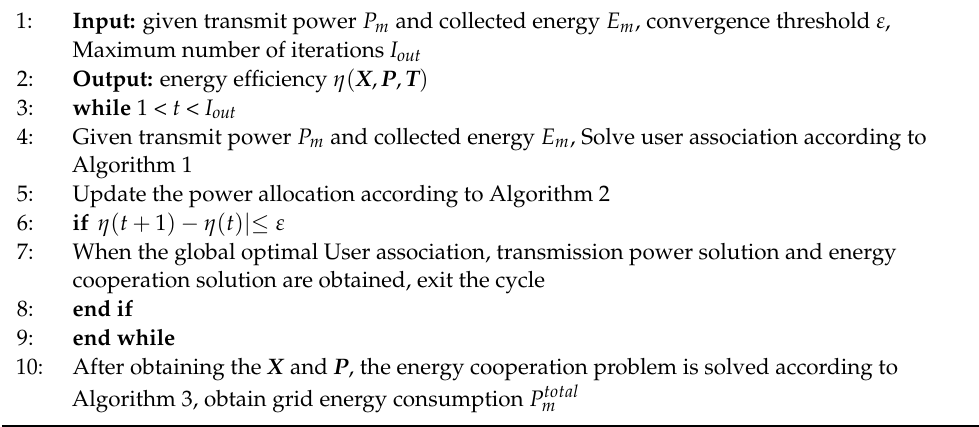
Algorithm 4 Joint User Association, Power Allocation and Energy Cooperation